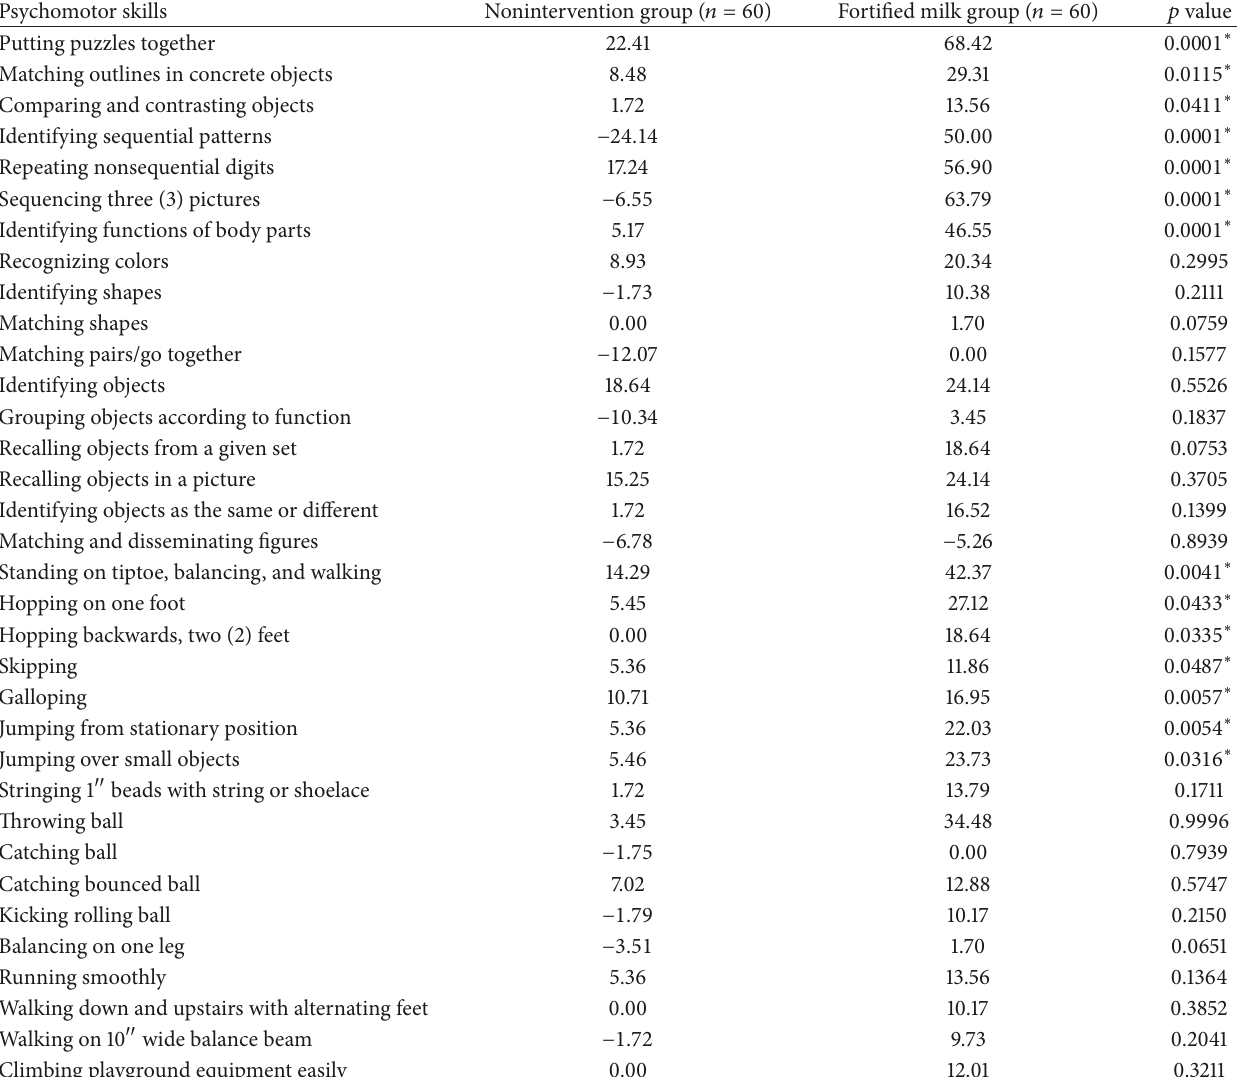
Table 9: Mean change in different psychomotor skills after twelve weeks of intervention adjusted for covariates (%). Psychomotor